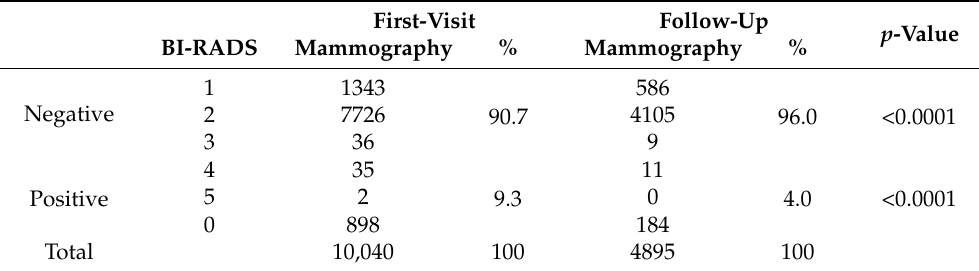
Table 1. Initial interpretation results of mammography images.